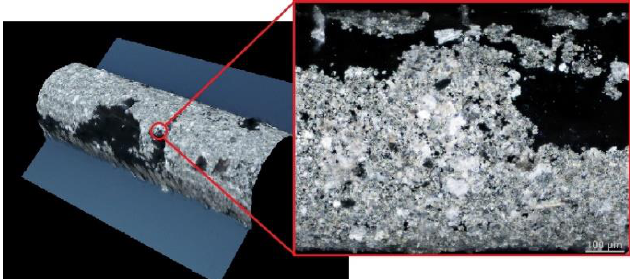
Figure 11. R–AgLAFE surface seen as an image from a Nikon Eclipse MA200 optical microscope with a “Nikon Lu Plan Fluor 10x/0.30A” objective.